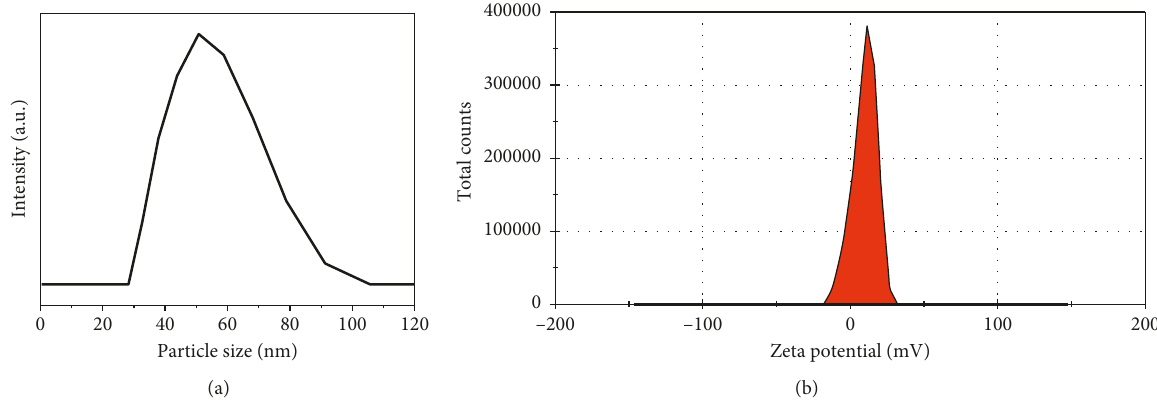
Figure 4: (a) DLS graph and (b) zeta potential graph of C-dots synthesized at 240 ° C.